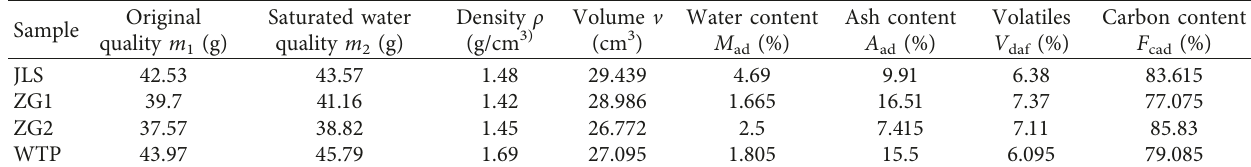
Table 1: The basic parameters and proximate analysis results of coal